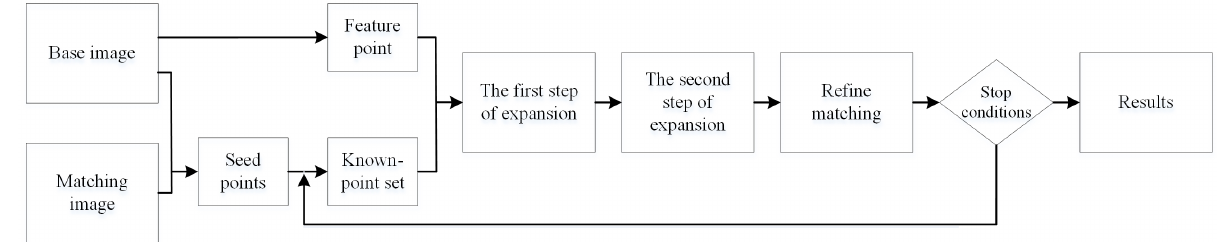
Figure 1. Pipeline of the proposed method